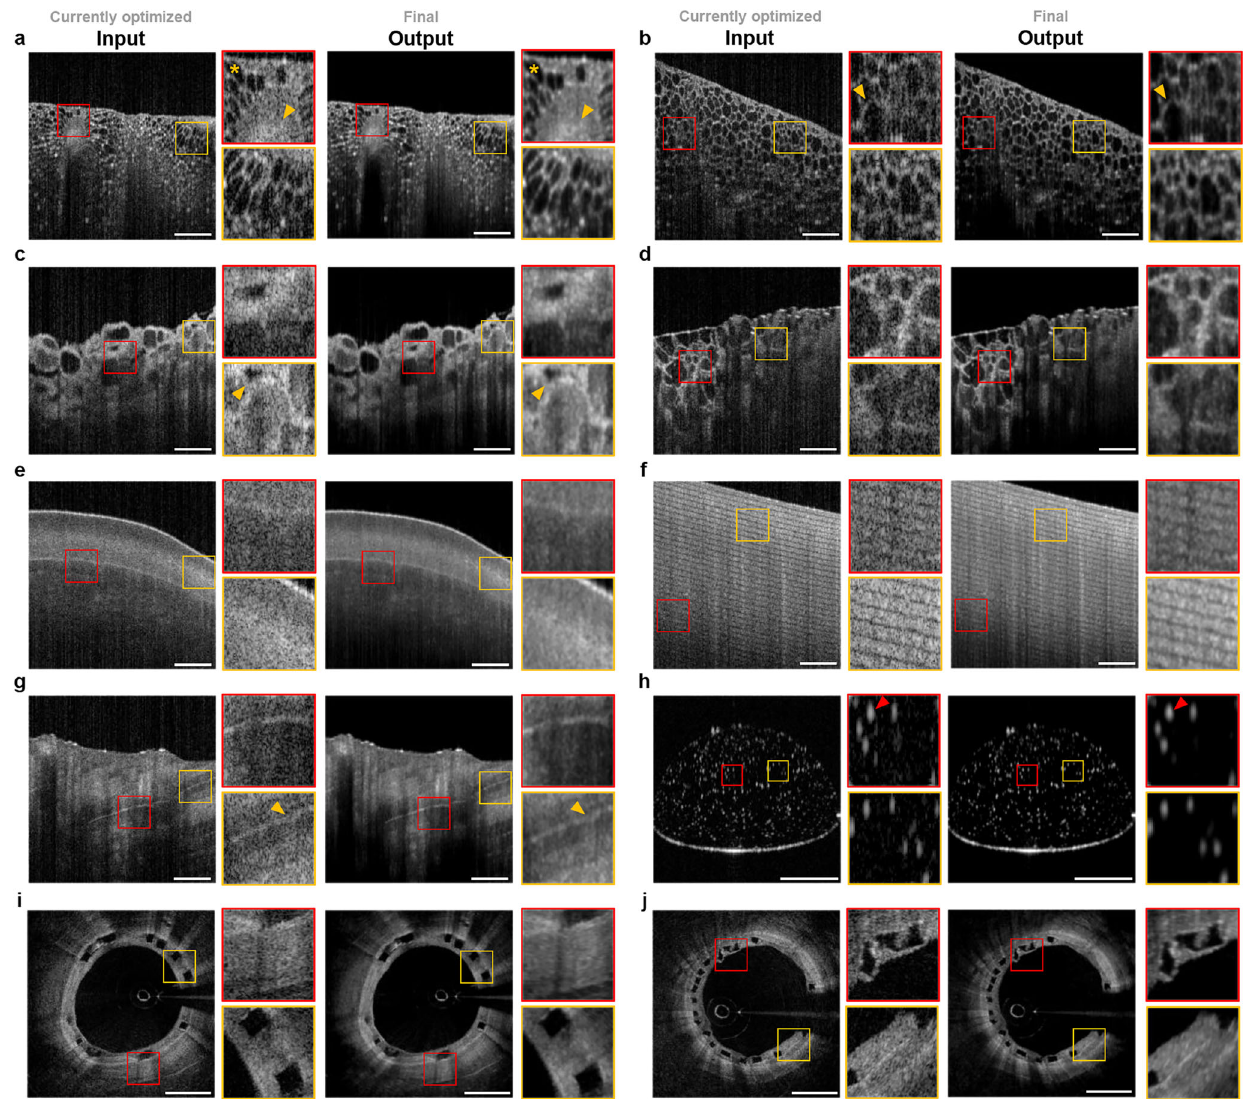
Fig. 3 Blind testing performance of deep learning-based OCT image enhancement framework. Left and right columns represent currently optimized input and enhanced fi nal output, respectively. Note that, in these results, the currently optimized OCT data were the input. Final output is the result of sequentially applying both NetA and NetB to the input. Each fi gure represents a cucumber, b grape, c , d thyroid tissue specimen, e fi nger nail, f Scotch tape, g pork meat, h droplet with TiO2 microspheres, and i , j arterial cross-section. The ROIs (red and yellow boxes) on the right side of the image show magni fi ed views (3X for a – g and i – j ; 5X for h ). Scale bars, 1